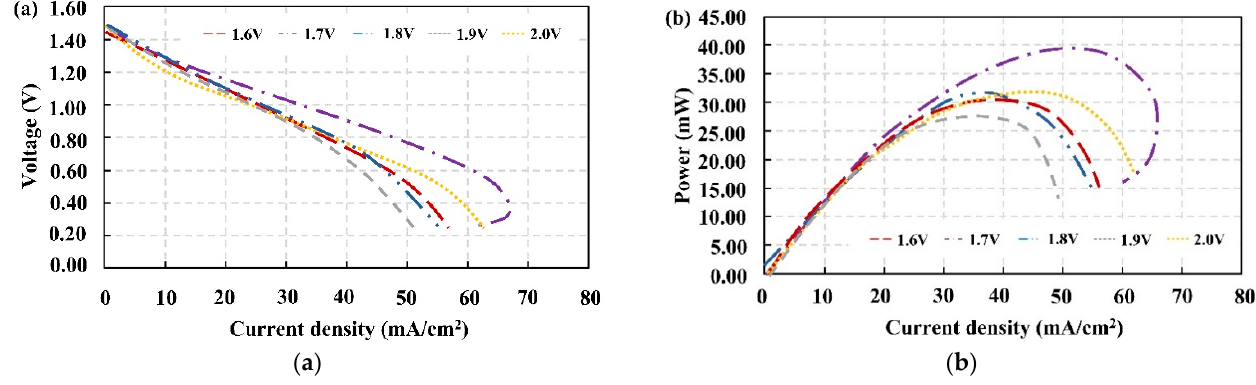
Figure 7. ( a ) Polarization curves and ( b ) power vs. current density plots obtained from the discharging process following electrolyte preparation with various applied voltages. Table 2. Maximum power and voltage efficiency obtained from polarization curves.